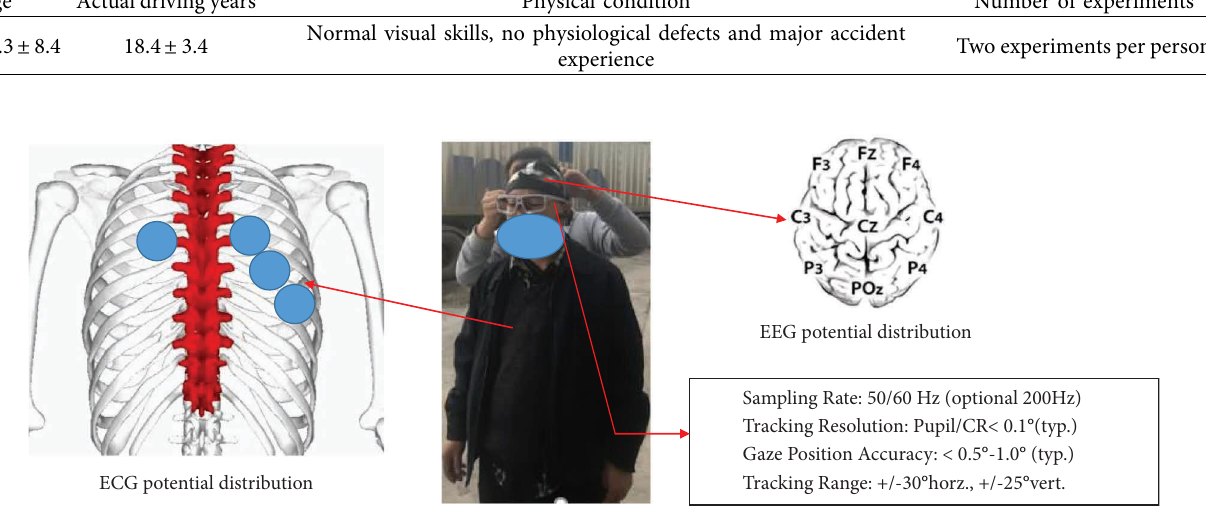
Figure 3: Subject wearing equipment.